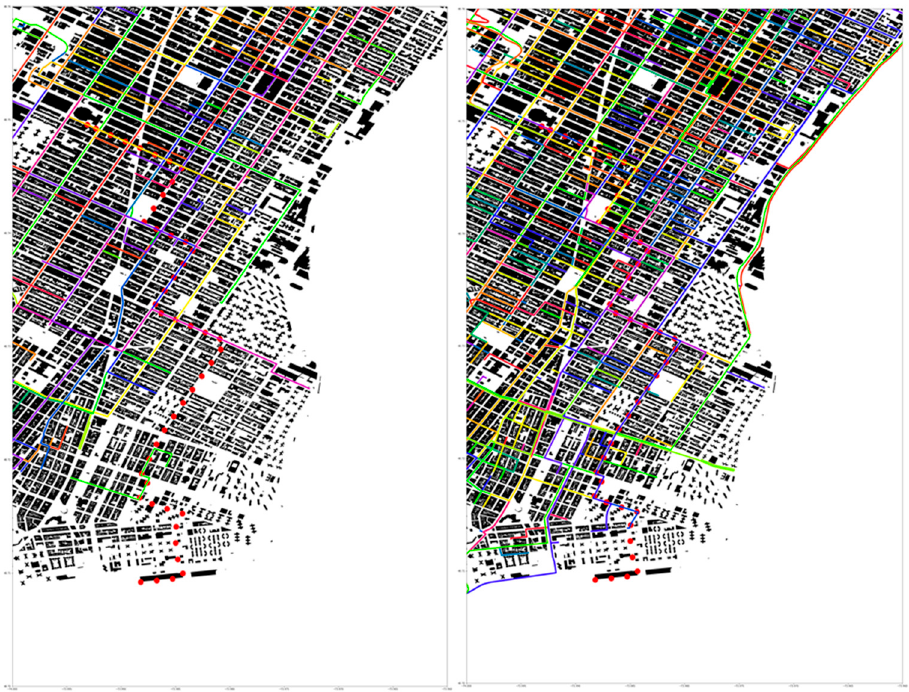
Figure 1. Visualization of 100 and 500 Uber routes on 3 December 2018. ( Left ) 100 Uber tracks and ( right ) 500 tracks sampled from 3500 routes that occurred between 3:00 pm and 3:20 pm on this date. The solid lines represent the Uber traffic. The red dotted line represents the source path. All journeys begin and end inside the 20-min duration. Journeys that start or finish outside the duration were excluded. This figure highlights the areas of good coverage and shows weaker coverage toward the coasts.